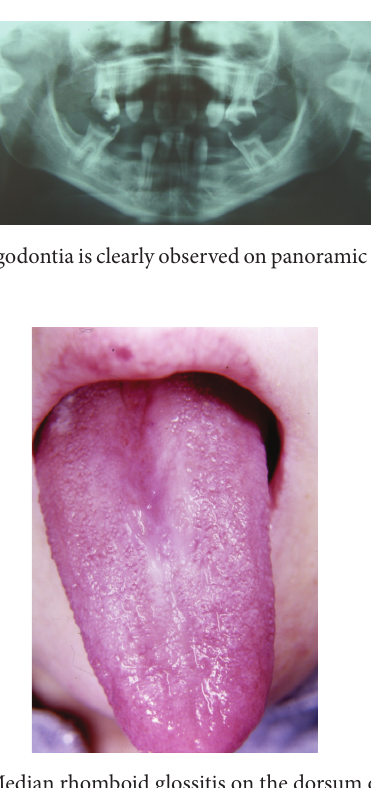
Figure 5: Median rhomboid glossitis on the dorsum of